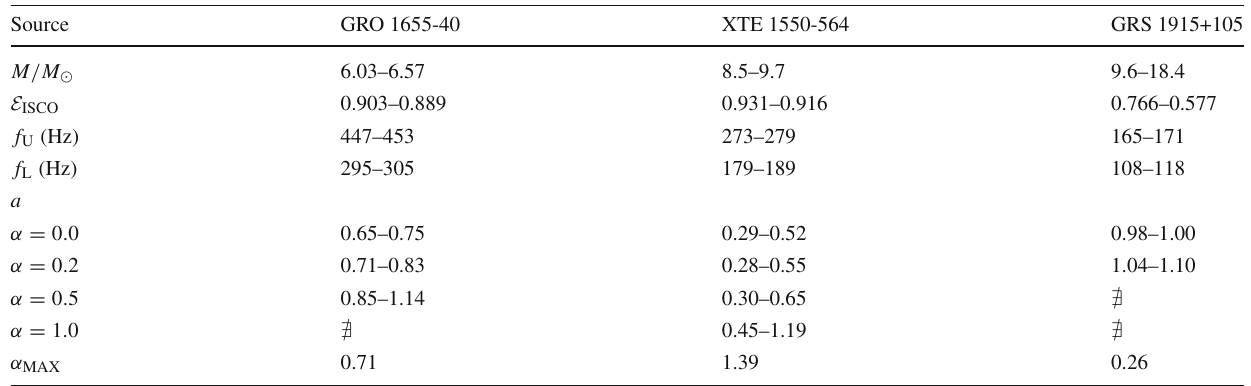
table). Note that in the GRS 1915+105 microquasar more HF QPOs are observed [9]. Here we concentrate attention to the pair of HF QPOs demonstrating the frequency ratio 3:2, common with those observed in other two